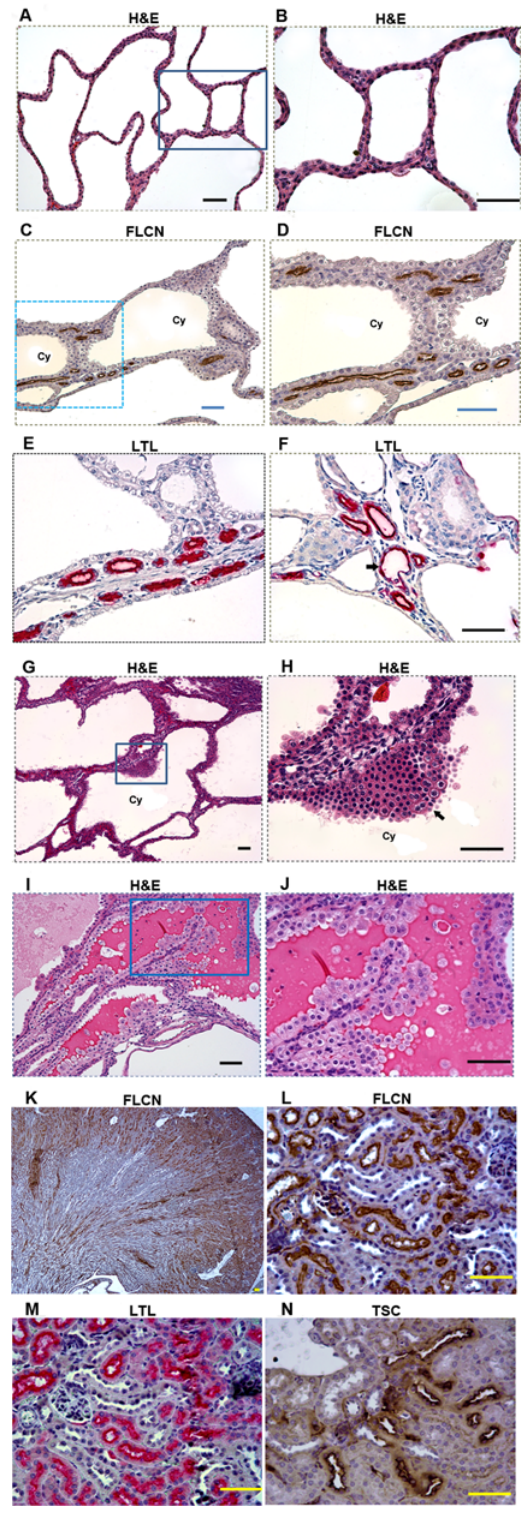
Figure 3. Inactivation of FLCN in BHD flox/flox /Ksp-Cre mice led to polycystic disease, hyperplasia, cystic renal cell RCC. ( A,B ) Deficiency of FLCN resulted in polycystic disease. ( C, D ) No FLCN expression was detected in cysts (enlarged tubules). However, FLCN was still expressed in relatively normal tubules where BHD was not deleted or completely eliminated by Ksp-Cre due to no or low